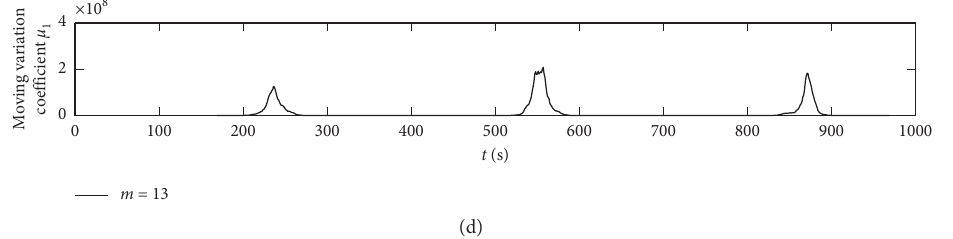
Figure 8: Calculation results of sinusoidal signal under different window lengths.